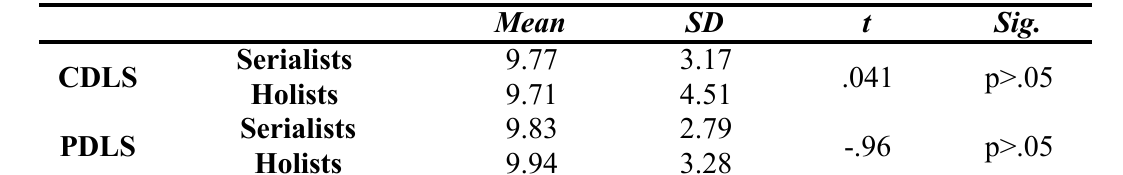
Students’ Prior Knowledge